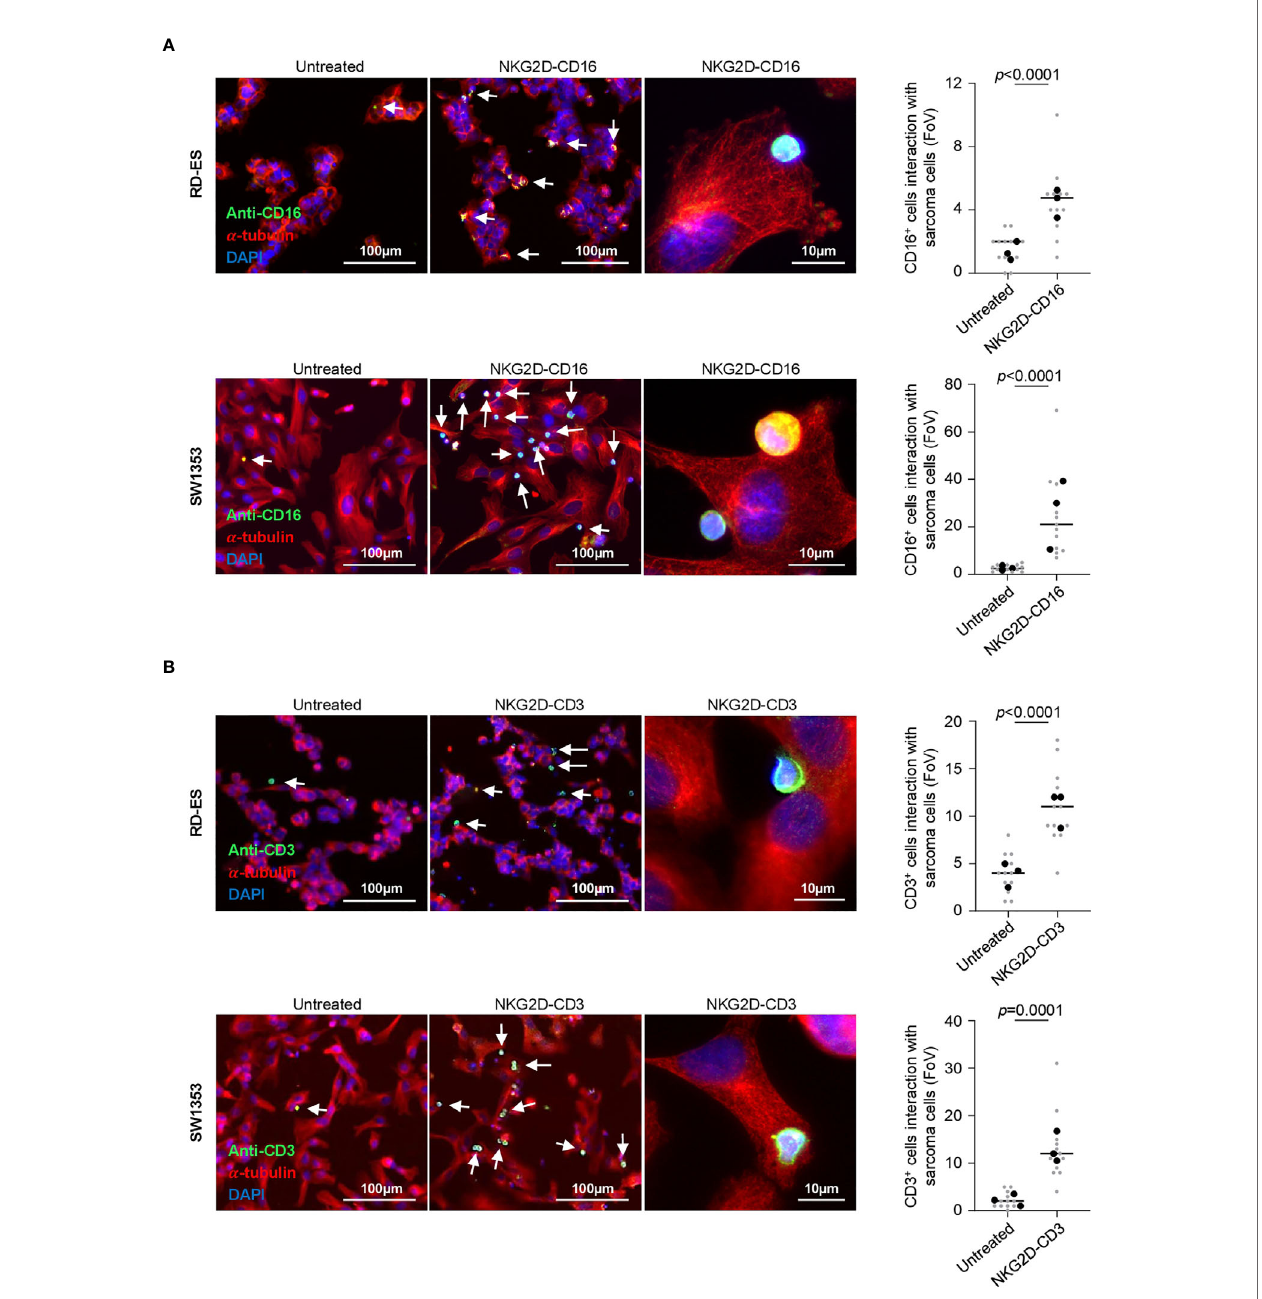
FIGURE 3 | Recruitment of NK and T cells to tumor cells via binding of NKG2D-CD3/CD16. The Indicated sarcoma cell lines were cultivated with PBMC of healthy donors (E:T 2.5:1) in the presence or absence of NKG2D-CD3/CD16 (2.5 µg/ml) and subsequently stained for a -Tubulin and (A) CD16 or (B) CD3. DAPI was used for counterstaining. Interaction of CD16 + and CD3 + cells was quanti fi ed by counting triple positive cells located at sarcoma cells. Grey and black dots represent individual analysis per FoV (n=12) out of three independent